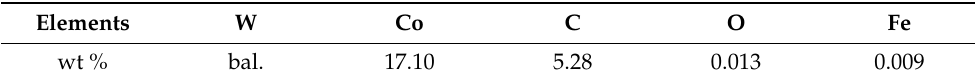
Figure 1. WC-17Co powders: ( a ) the low-magnification SEM micrographs of powders, ( b ) the high-magnification SEM micrographs of powders, and ( c ) the particle size distribution of powders. Table 1. Chemical composition of the WC-17Co powders.